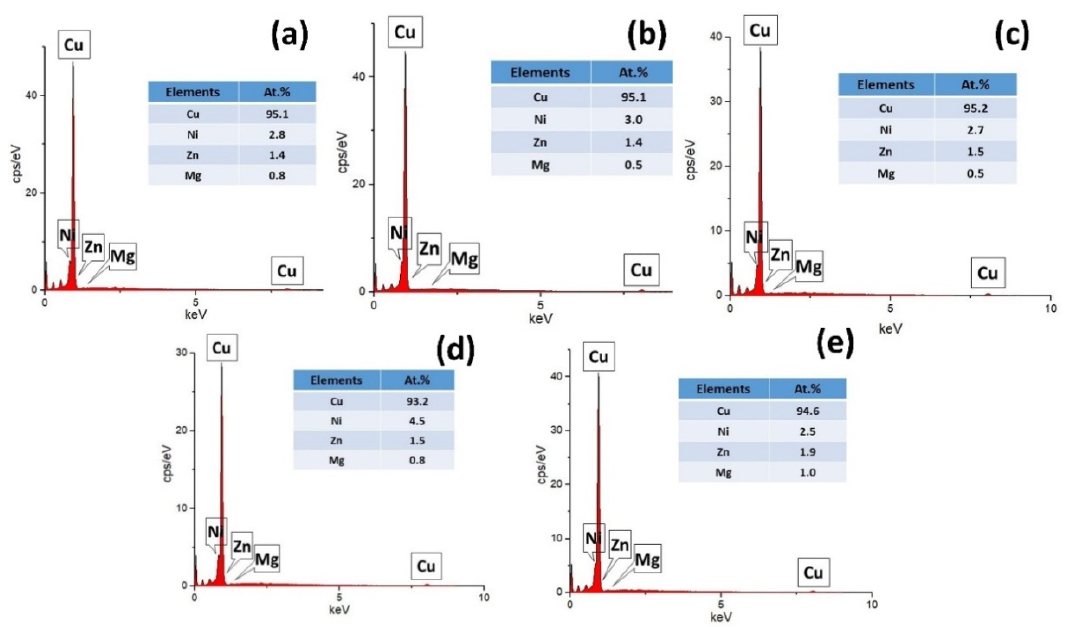
Figure 5. EDS analysis corresponding to ( a ) Map Sum spectrum for Figure 3a ( b ) Point Spectrum 1 ( c ) Point Spectrum 2 ( d ) Point Spectrum 3 ( e ) Point Spectrum 4.